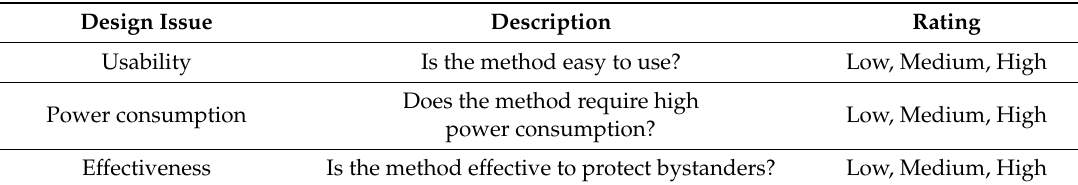
Table 2. Design issues for bystanders’ facial privacy solutions.